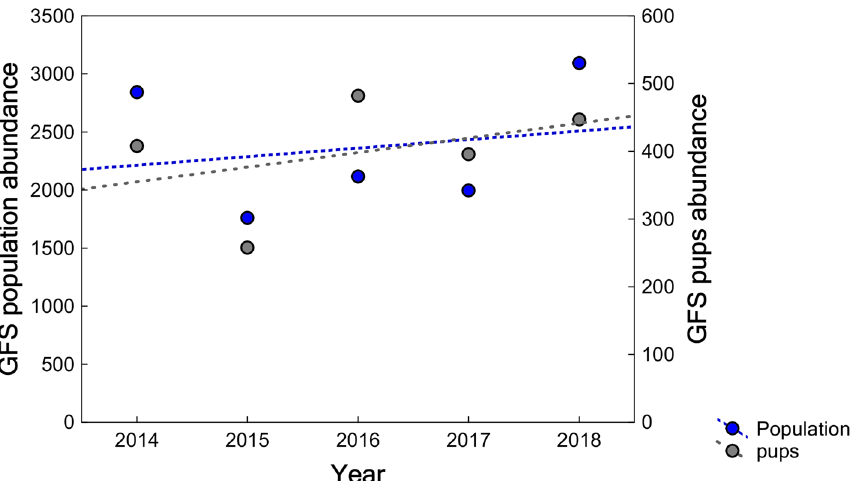
Figure 3. Galapagos fur seals’ population and pup abundance trend in the Galapagos Archipelago from 2014 to 2018. It includes the annual counts at 11 breeding rookeries on seven islands distributed in the western, northern and central regions of the archipelago which this species inhabits. Blue and gray circles show the total population and pup population, respectively. The blue dashed line shows the population trend.